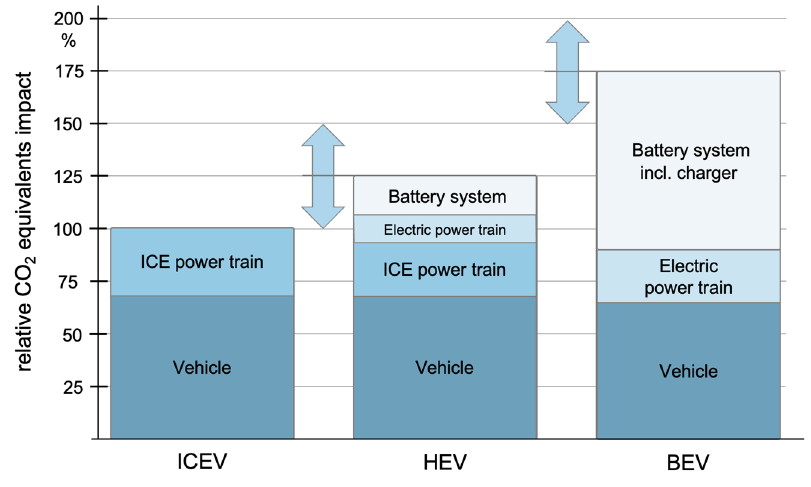
Figure 5. CO 2 -equivalent-emission impacts of vehicle production in comparison.